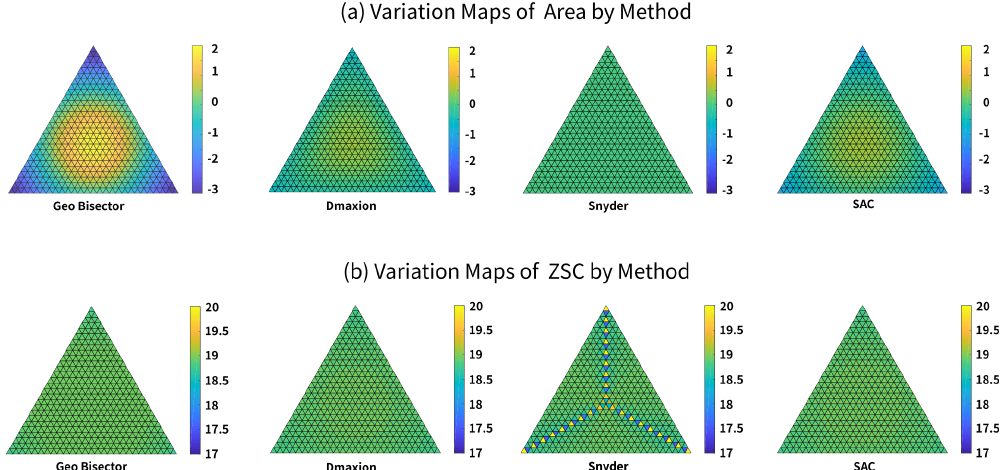
Figure 26. Maps of the spatial variation in the area and ZSC measurements for the Geo Bisector, Snyder, Dymaxion, and SAC methods for the icosahedron and 9-fold density